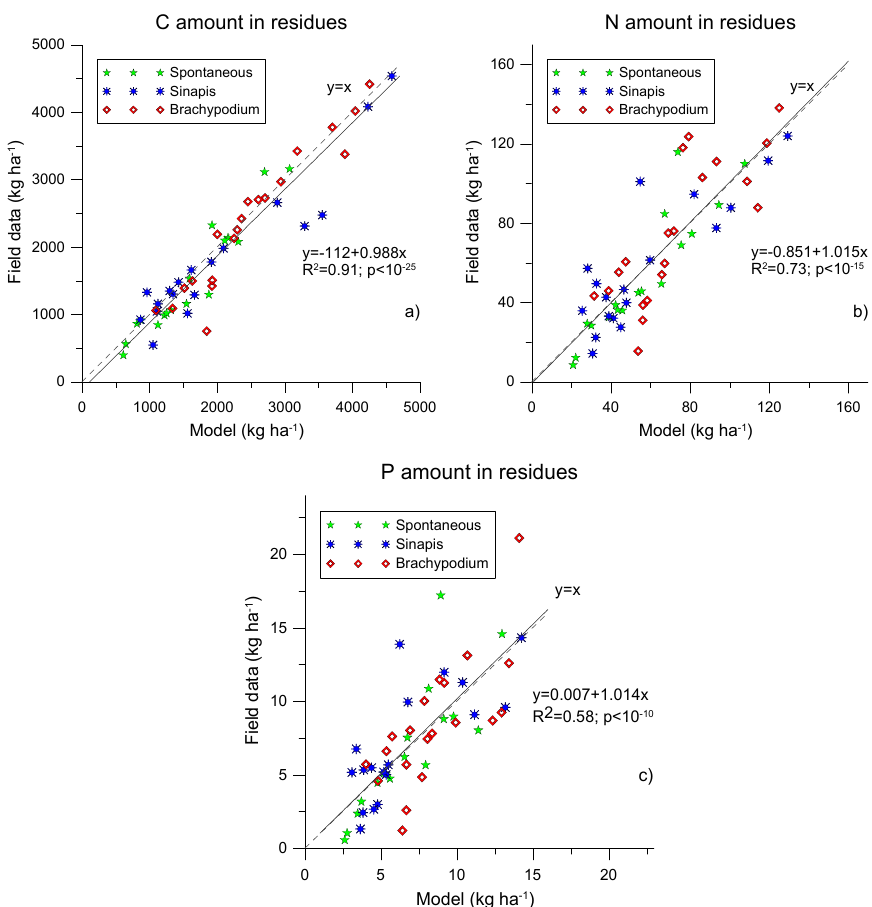
Figure 5. Measured versus estimated C ( a ), N ( b ) and P ( c ) amounts in the aboveground residues for the three types of cover crops and 4-year field trial. The dashed line is 1:1, and the straight line is the regression line.